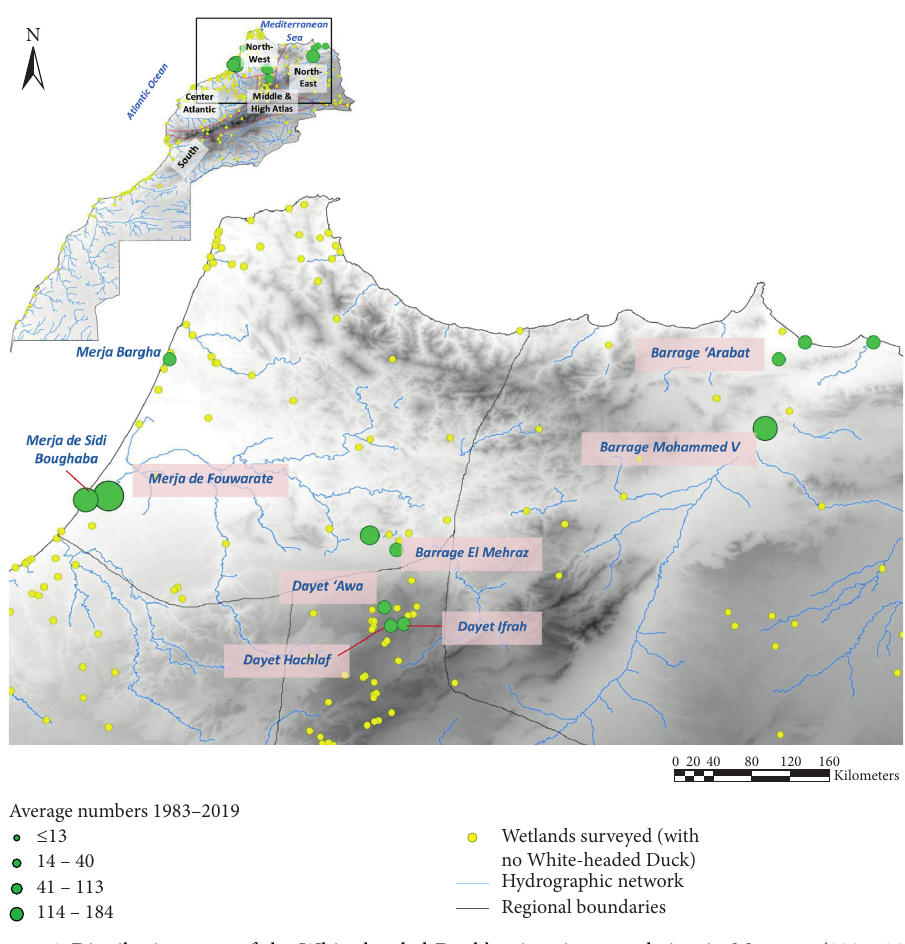
Figure 6: Distribution map of the White-headed Duck’s wintering population in Morocco (2005–2019). Table 4: Most important wintering sites of the White-headed Duck